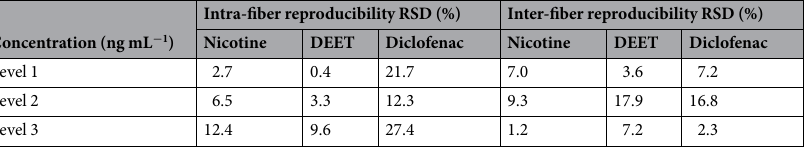
Table 2. Precision of the method in PBS only matrix. For nicotine and DEET: Level 1: 25 ng mL − 1 , Level 2: 100 ng mL − 1 , Level 3: 1000 ng mL − 1 . For diclofenac: Level 1: 10 ng mL − 1 ,Level 2: 100 ng mL − 1 , Level 3: 1000 ng mL − 1 . Inter-fiber reproducibility n = 4, intra-fiber reproducibility n = 3; experimental conditions: same as conditions given in the text, desorption volume: 0.1 mL.